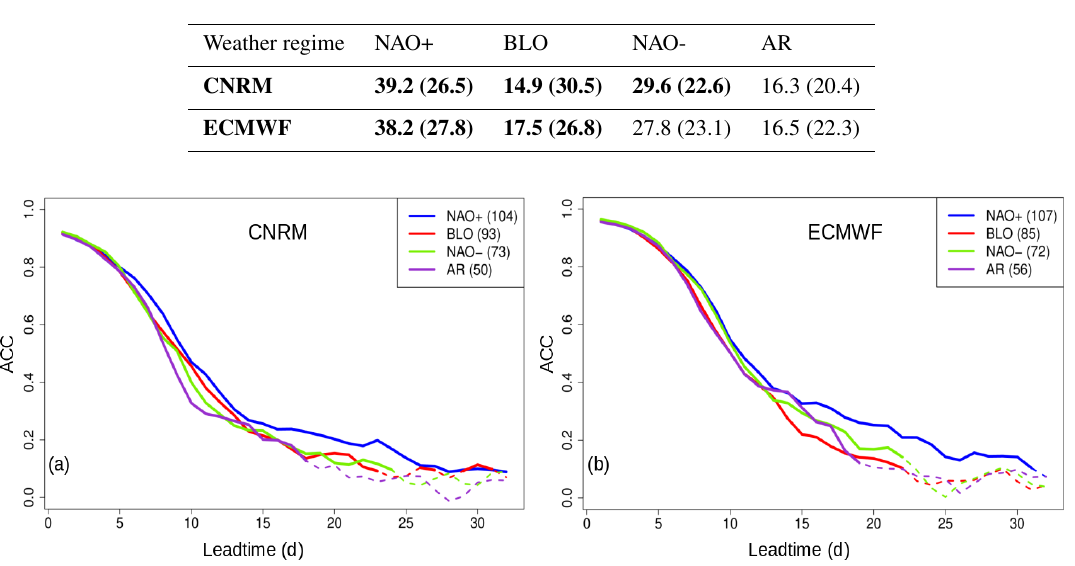
Table 2. Initial weather regime frequency in percent of skillful forecasts over EUR. Numbers in parentheses indicate the frequency for all the other forecasts. Bold characters highlight where the regime frequencies of skillful forecasts are significantly different from those in parentheses at the 95% confidence level as determined by the bootstrapping method.